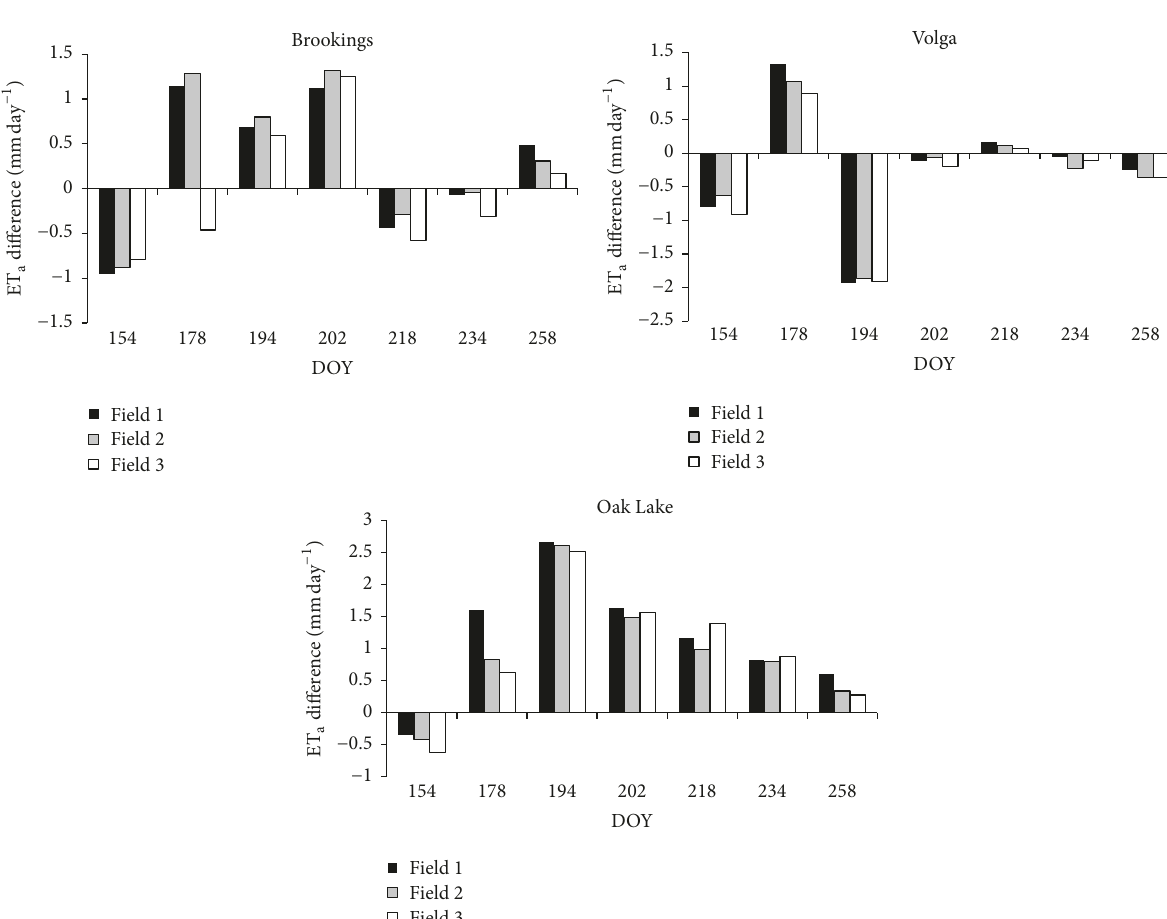
difference between ET a